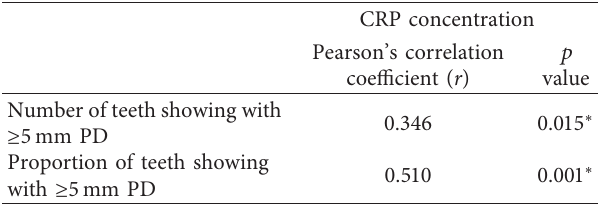
Pearson’s correlation coefficient. ∗ Significant difference ( p < 0 .